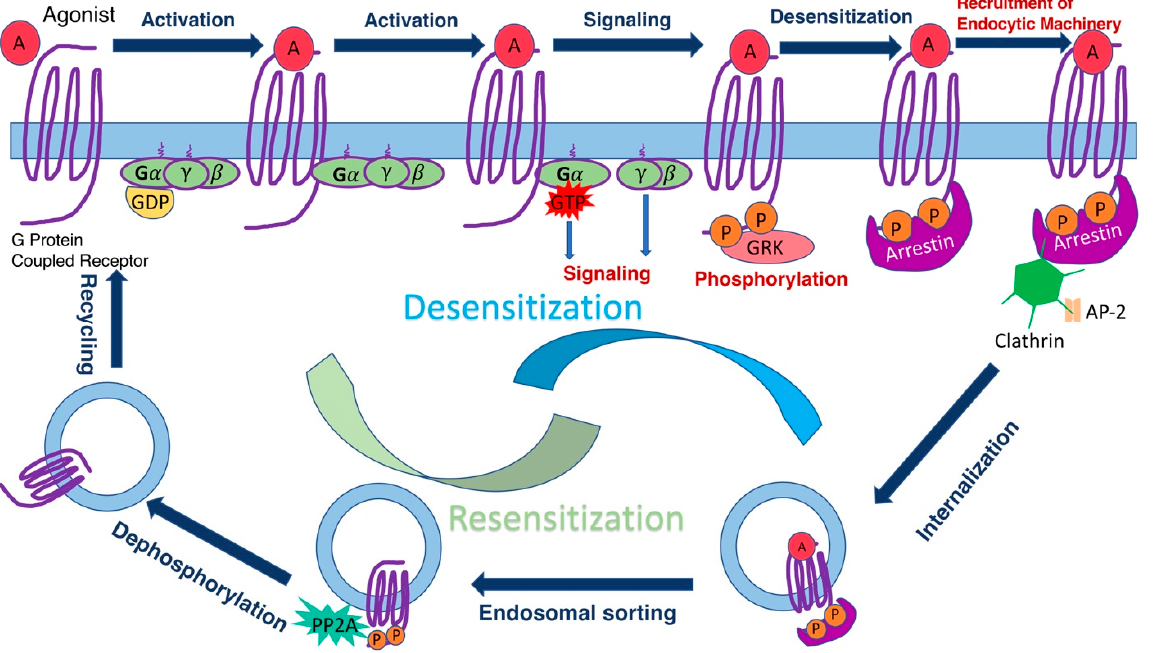
Figure 1. GPCR signaling, desensitization, and internalization. GPCRs (purple) are transmembrane proteins that mostly localize to the plasma membrane (light blue). GPCRs are activated by agonist (A in red circle) binding. Active receptor binds inactive (GDP-liganded) heterotrimeric G protein consisting of α -, β -, and γ -subunits (where α - and γ -subunits have lipid modifications shown as purple tails inserted into the membrane). Receptor binding opens the nucleotide pocket in the G protein α -subunit, leading to the release of bound GDP and binding of GTP, which is more abundant in the cytoplasm. GTP-liganded G protein dissociates from the receptor as a separated α -subunit-GTP and βγ -dimer, both of which interact with various effectors to initiate signaling. Active GPCRs are recognized by specialized GPCR kinases (GRKs, pink oval) that phosphorylate many GPCRs at the C-terminus, although in some receptors, GRK phosphorylation sites are localized on other cytoplasmic elements. Arrestins (magenta) bind active phosphorylated GPCRs and via direct interac- tions recruit main components of the endocytic machinery of the coated pit, clathrin (green hexagon), and clathrin adaptor AP-2 (yellow), thereby promoting receptor internalization. The internalized receptor is deactivated by the loss of agonist in the acidic environment of the endosome. This facilitates arrestin dissociation, which makes receptor-attached phos- phates accessible for the phosphatases (possibly PP2A, shown in green). The dephosphorylated receptor can be recycled back to the plasma membrane and reused. Some internalized GPCRs are sent to lysosomes for degradation (not shown). This reduces the number of receptor molecules in the cell (downregulation). Only four subtypes of arrestin proteins are expressed in most vertebrates (bony fish that underwent an extra round of whole genome duplication express more) [15]. Arrestin- 1 and -4 are the two visual subtypes present in photoreceptor cells in the retina. Their function is to regulate phototransduction cascades, i.e., quench photopigment signaling in rods and cones [16]. Arrestin-2 and -3 are ubiquitously expressed and regulate hun- dreds of GPCR subtypes involved in a wide range of signaling pathways [3,4]. Arrestin-1 displays the highest selectivity for active phosphorylated rhodopsin, as compared to its other functional forms [11], including retinal-free opsin [17]. Therefore, it was used to elu- cidate the mechanism of arrestin activation and its binding to various functional forms of cognate receptors. Similar to rhodopsin, non-visual GPCRs can be in an active or inactive state, unphosphorylated or phosphorylated. It should be noted, though, that in contrast to rhodopsin, which exists in the dark with covalently attached inverse agonist 11-cis- retinal, effectively suppressing its constitutive activity (reviewed in [18]), non-visual GPCRs in an unliganded state, as well as occupied by various ligands, sample a variety of conformations [19]. Additionally, in rhodopsin, all GRK-phosphorylated residues are compactly localized in a short stretch in the C-terminus [13], while in other receptors, GRK targets can be in the C-terminus or cytoplasmic loops, often in more than one receptor element (e.g., see several examples in [20] and more general discussion in [3]). However,